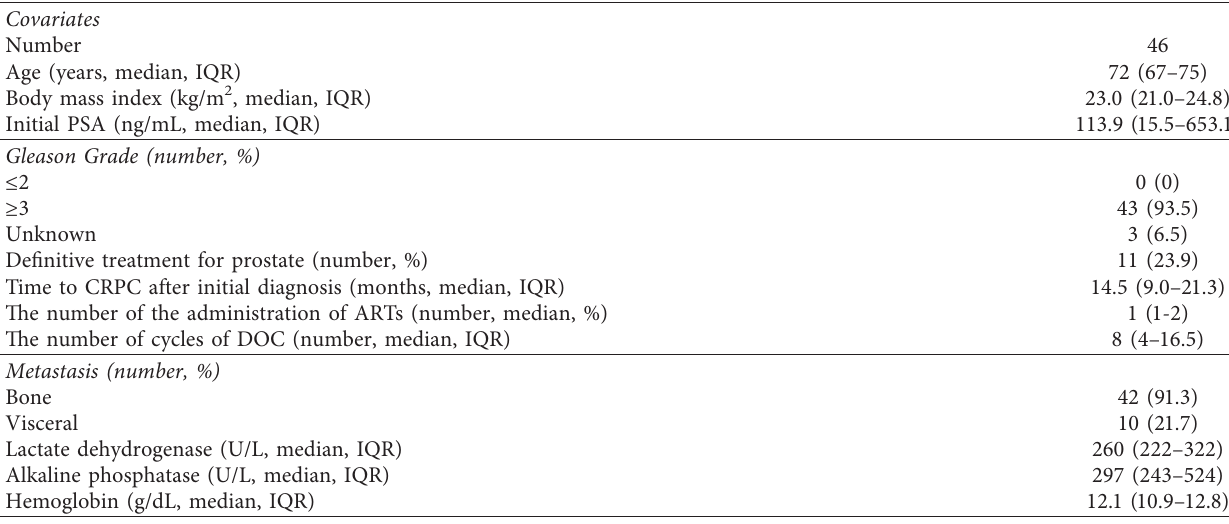
Table 1: Patient characteristics.